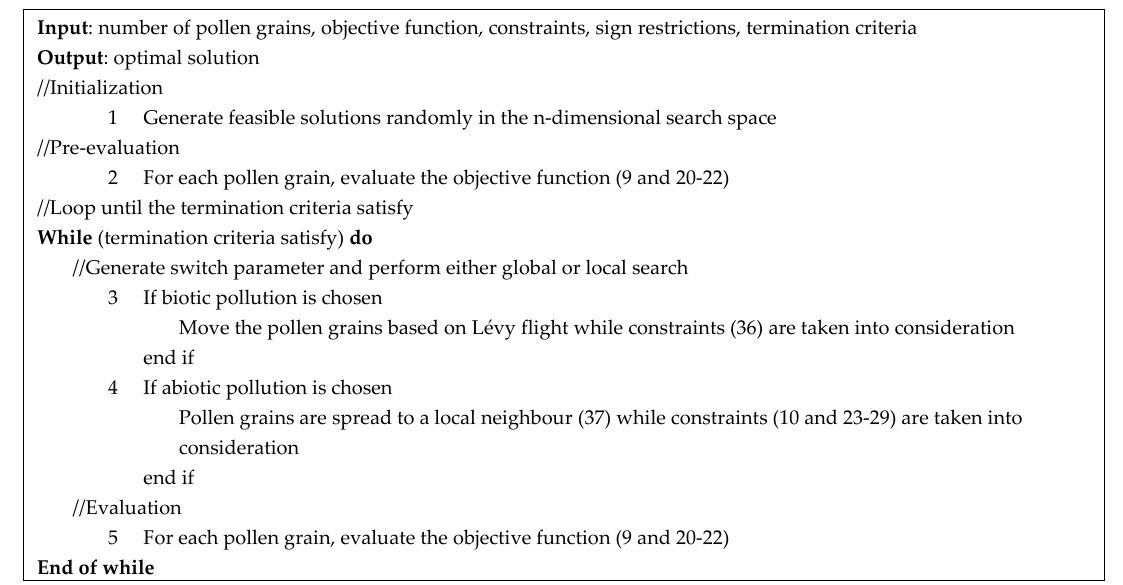
Figure 14. Pseudocode of the implementation of black hole algorithm for clustering of supply-demand in the extended phase of logistics resource optimization.